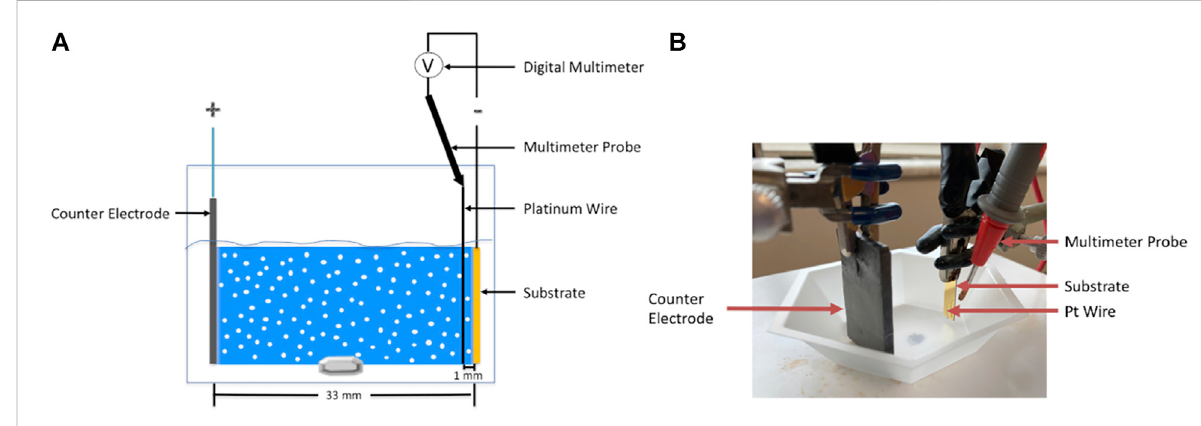
FIGURE 3 (A) Schematic and (B) the corresponding photograph of the electrophoretic deposition